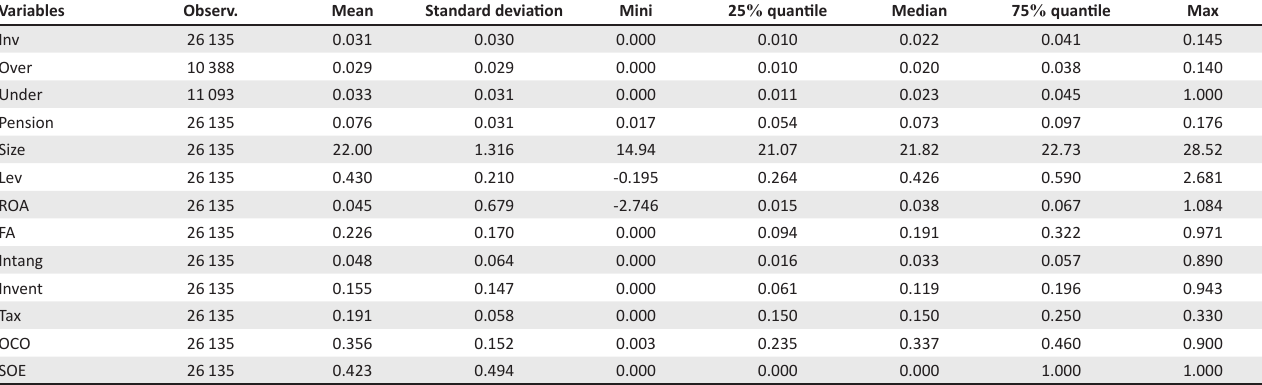
TABLE 4: Descriptive statistics of the quantitative variables. Variables Observ.